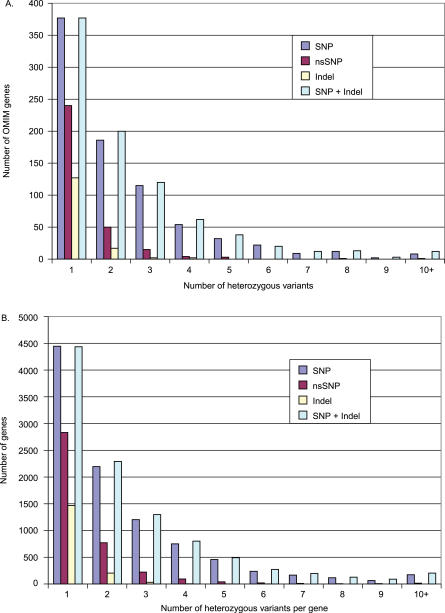
Distribution of HuRef Variants in OMIM and Ensembl Genes(A) The distribution of the OMIM genes in Ensembl version 41 protein coding genes that contain one or more SNP or indel in their coding and/or UTR regions. (B) A similar distribution for the variants found in coding and/or UTR regions for all Ensembl version 41 genes.